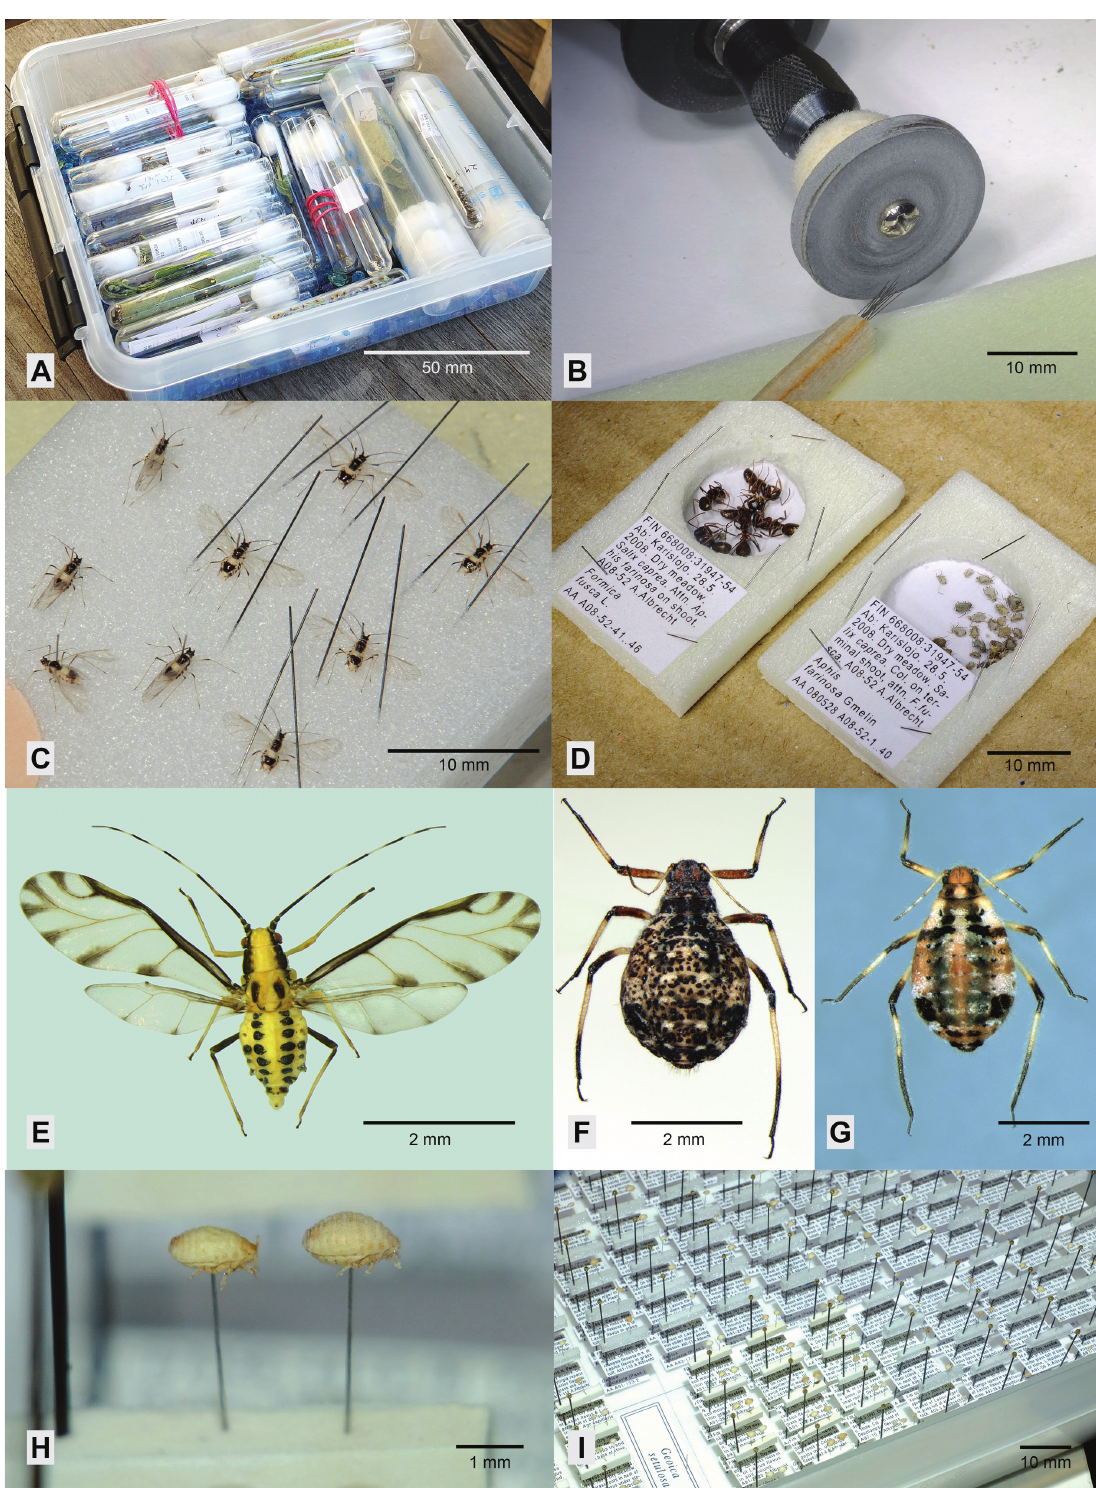
Fig. 1. A . Freeze-drying container with samples and silica-gel on bottom. B . equipment for sharpening micro pins. C. Foam plate with pinned aphids ( Hyperomyzus lampsanae (börner, 1932)). D . Foam polyurethane storage vials ( Formica fusca linnaeus, 1758 and Aphis farinosa Gmelin, 1790). E–I . Pinned freezedried aphids. E . Eucallipterus tiliae (linnaeus, 1758) . F . Cinara laricis (hartig, 1839) . G . Cinara pruinosa (hartig, 1841) . H–I . Geoica utricularia (Passerini,